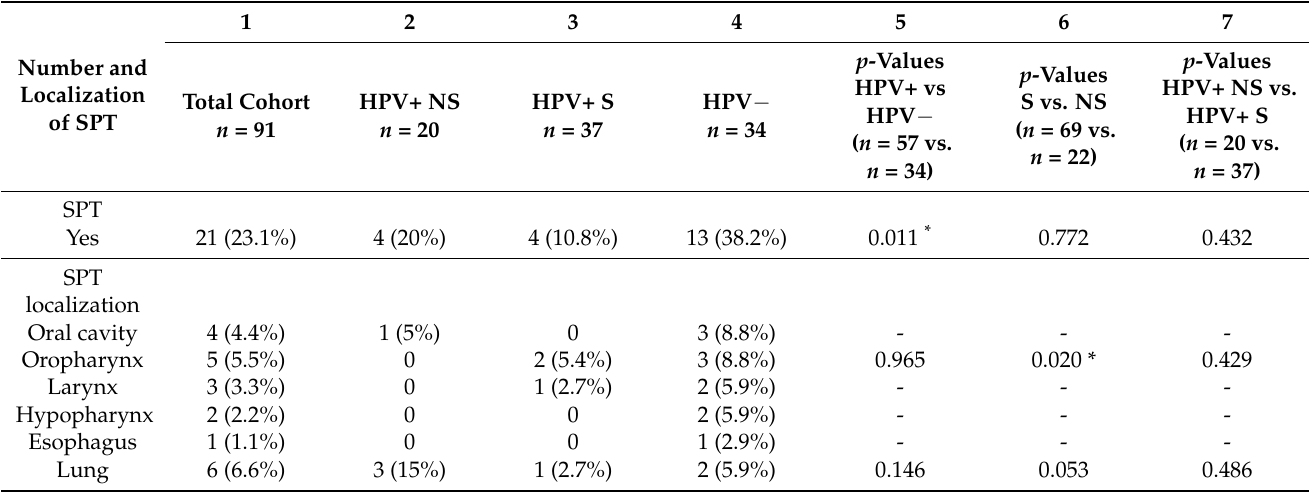
Table 2. Overview of the number and locations of SPT of HPV-positive nonsmokers, HPV-positive smokers, and HPV- negative patients. The table compares the number of SPT, as well as the number of SPT at specific locations, between HPV-positive and HPV-negative patients, smokers and nonsmokers, and between HPV-positive nonsmokers and HPV- positive smokers using a two-sided Fisher’s exact test. Results statistically significant at the 5% significance level are marked with *. Abbreviations: HPV = human papillomavirus, NS = nonsmokers, S = smokers, + = positive, − = negative, SPT = second primary tumors.